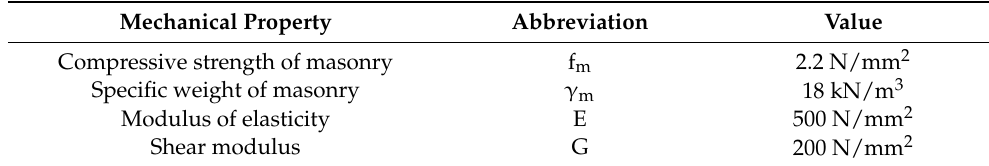
Table 2. Masonry mechanical properties.